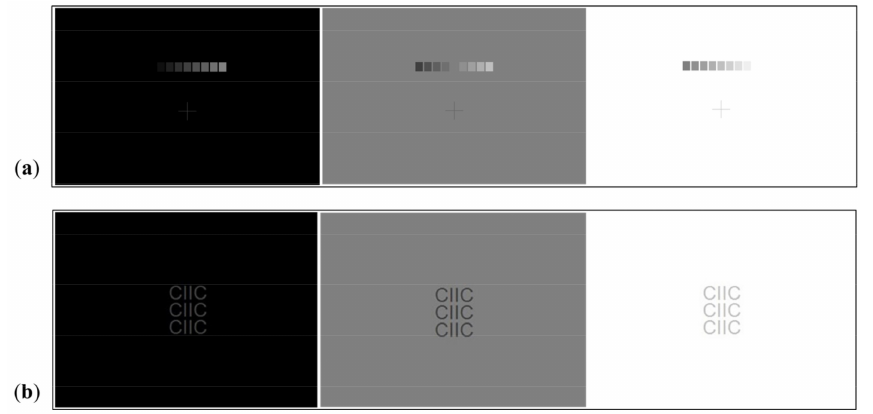
Figure 5. Illustration of ( a ) grayscale series in each background ( b ) low-contrast